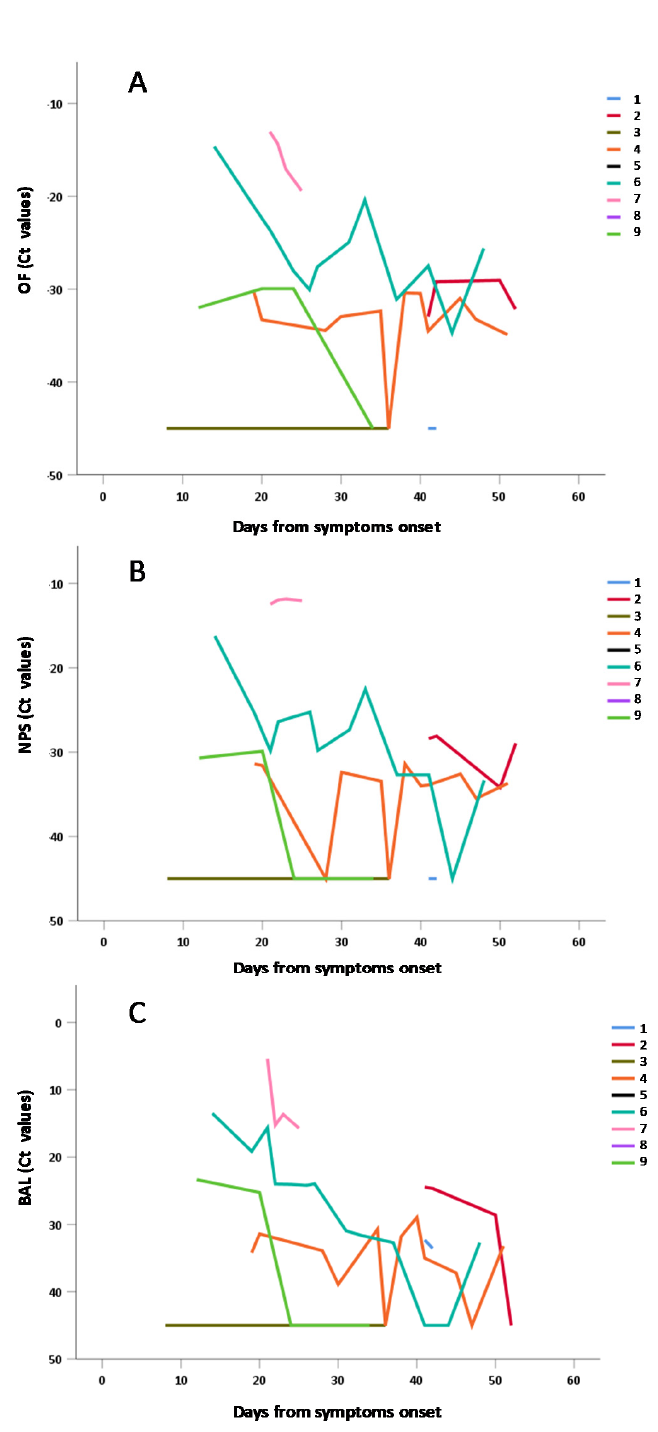
Figure 6. Shedding of SARS-CoV-2 RNA in OF ( A ), NPS ( B ) and BAL ( C ) NPS samples from individuals with repeated measures, according to days from symptoms.